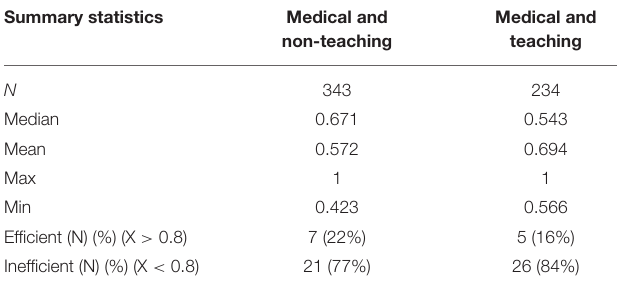
TABLE 4 | Overall efficiency results. TABLE 5 | The relationship between efficiency score and contextual